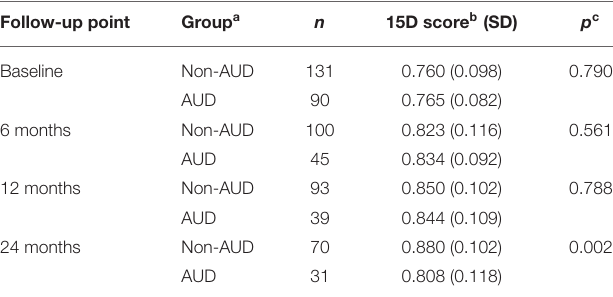
TABLE 2 | Health-related quality of life according to 15D score during 24 months of follow-up among Ostrobothnian Depression Study patients with or without baseline alcohol use